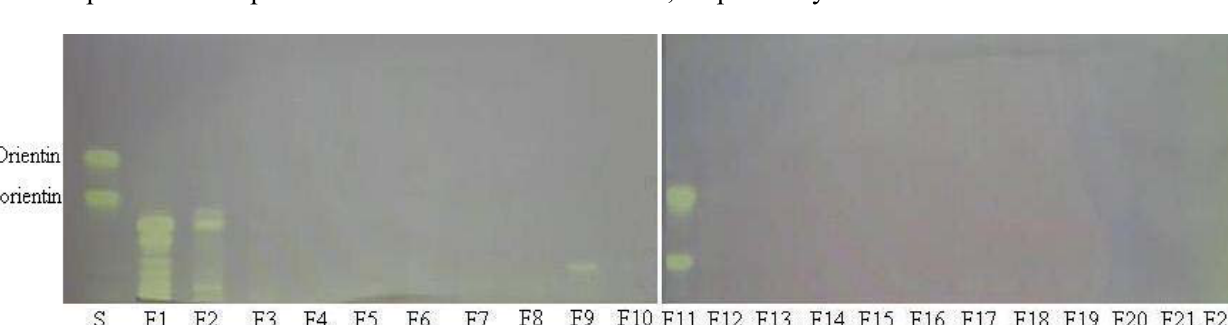
Figure 5. TLC photography of standards and fractions of B. textilis McClure leaf extracts colorized with 0.05% DPPH. S: Standards are isoorientin and orientin. Lanes F1–F22 in the picture correspond to fraction F1 to fraction F22,